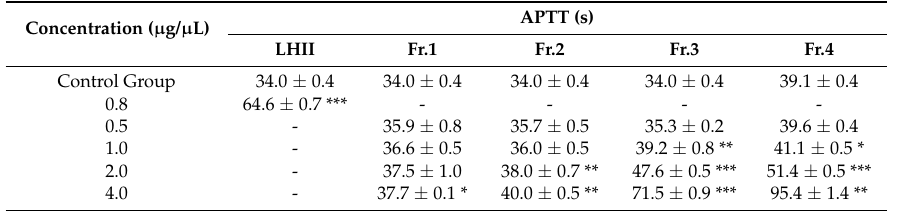
Table 1. Activated thromboplastin time (APTT) of fractions Fr.1, Fr.2, Fr.3, and Fr.4. Values are expressed as the mean of three measurements ± SD ( n = 3). Concentration is the concentration of the sample in the testing